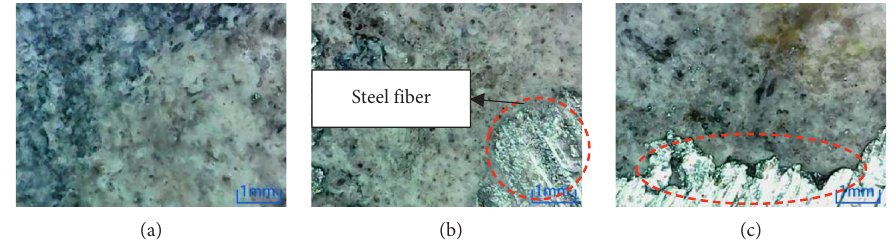
Figure 31: Microscopic observation of specimen soaked in NaOH solution at position 2. (a) 0%. (b) 1%. (c) Table 3: Results of concrete strength analysis. Environmental erosion conditions